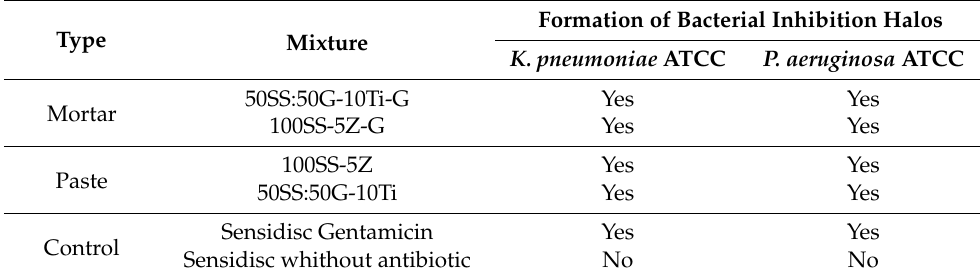
Table 7. Inhibition halos obtained in the culture of the ATCC strains of K. pneumoniae and P. aeruginosa with the evaluated materials and